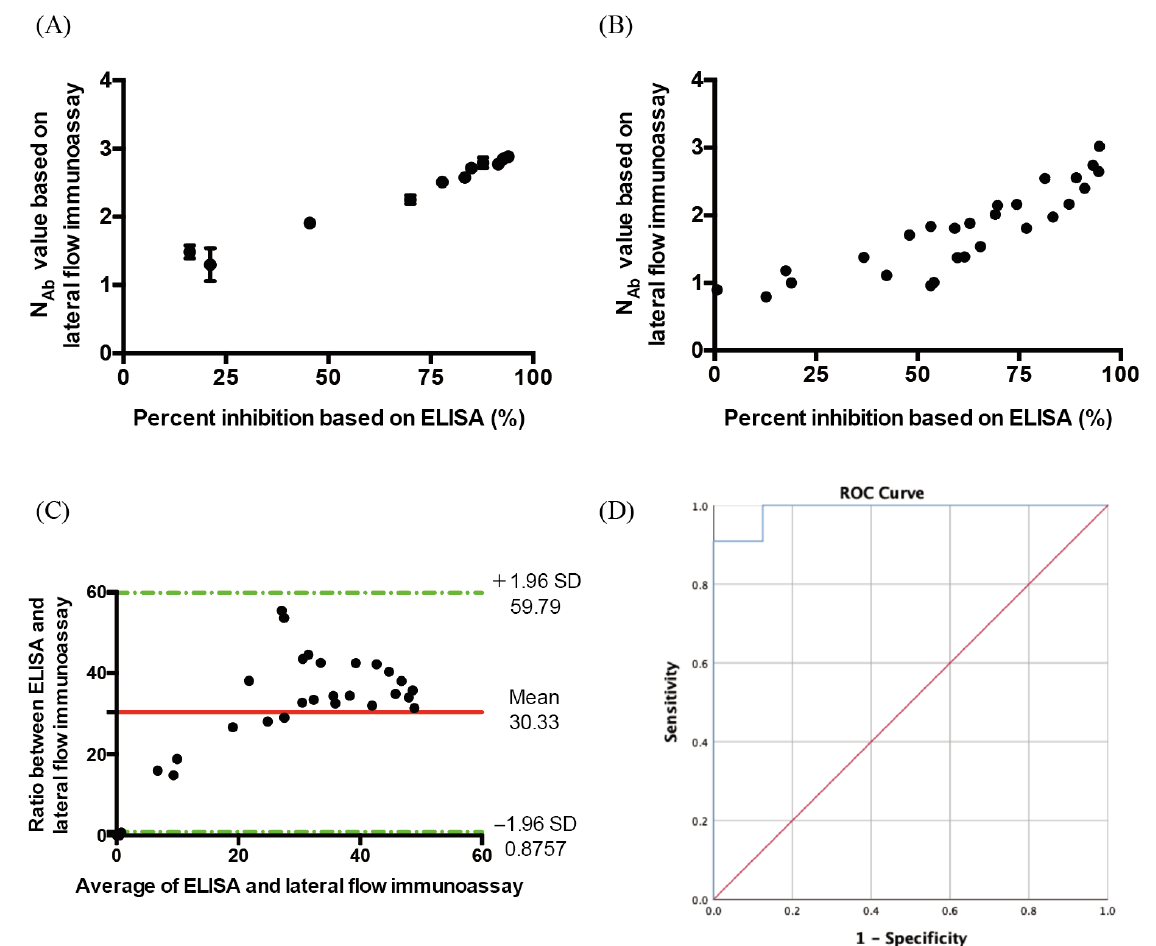
Figure 3. ( A ) Comparison of the lateral flow immunoassay and ELISA for the neutralizing antibody using diluent series serum from a severe case (Rho = 0.9818, p -value < 0.0001). The x -axis is the unit of percent inhibition based on ELISA. The y -axis is the unit of N Ab value based on the lateral flow immunoassay. ( B ) Comparison of the lateral flow immunoassay and ELISA for the neutralizing antibody using serum from patients, including 26 mild cases and 4 severe cases ( n = 30) (Rho = 0.9288, p -value < 0.0001). The x -axis is the unit of percent inhibition based on ELISA. The y-axis is the unit of N Ab value based on the lateral flow immunoassay. ( C ) Bland and Altman plot. The ratio between of the two measurements ( n = 30). Green lines indicate the limits of agreement ( ± 1.96